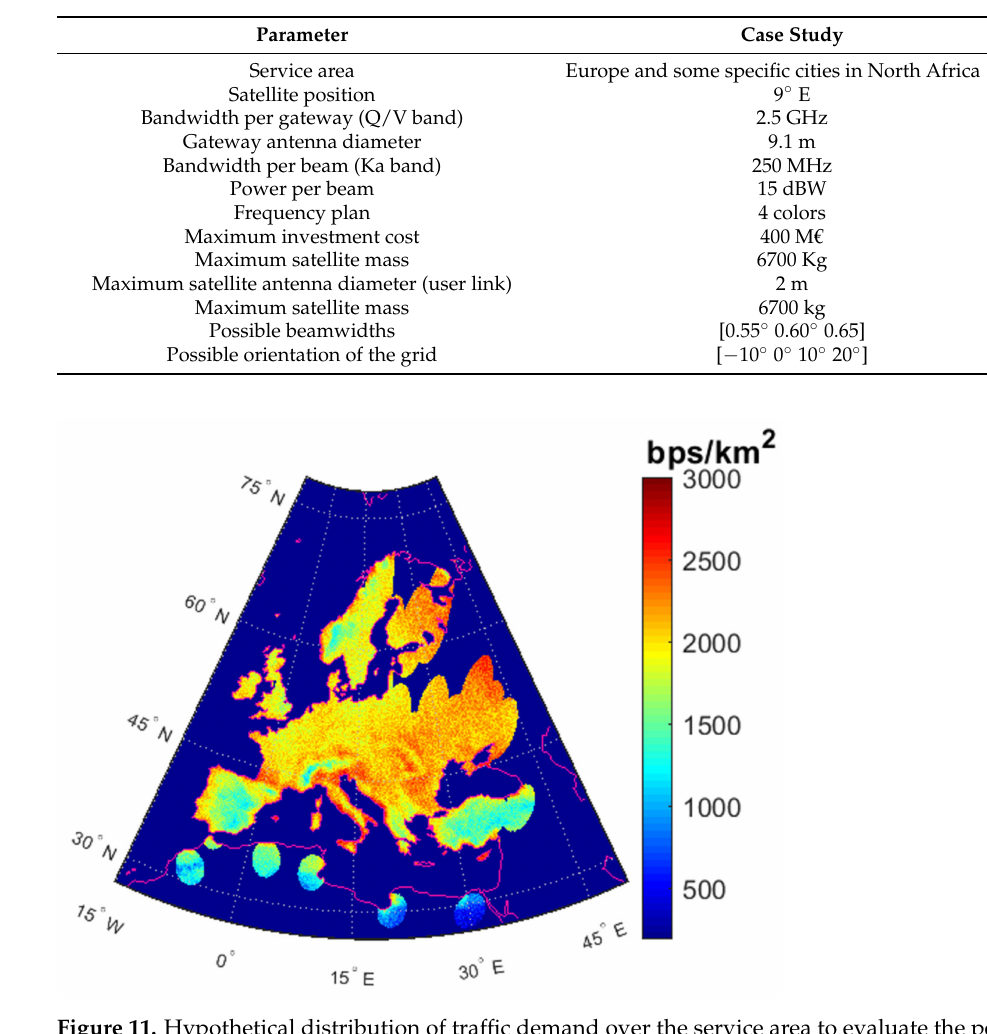
Table 1. Features and constraints of the proposed case study system.